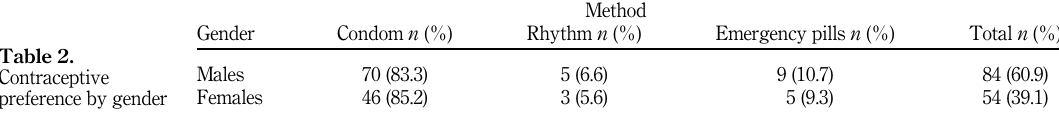
Table 1. General characteristics of the participants